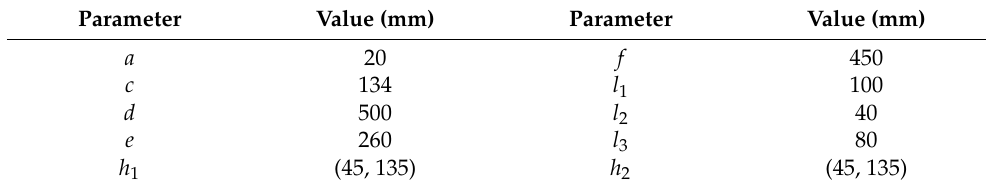
Table 2. The parameters of the